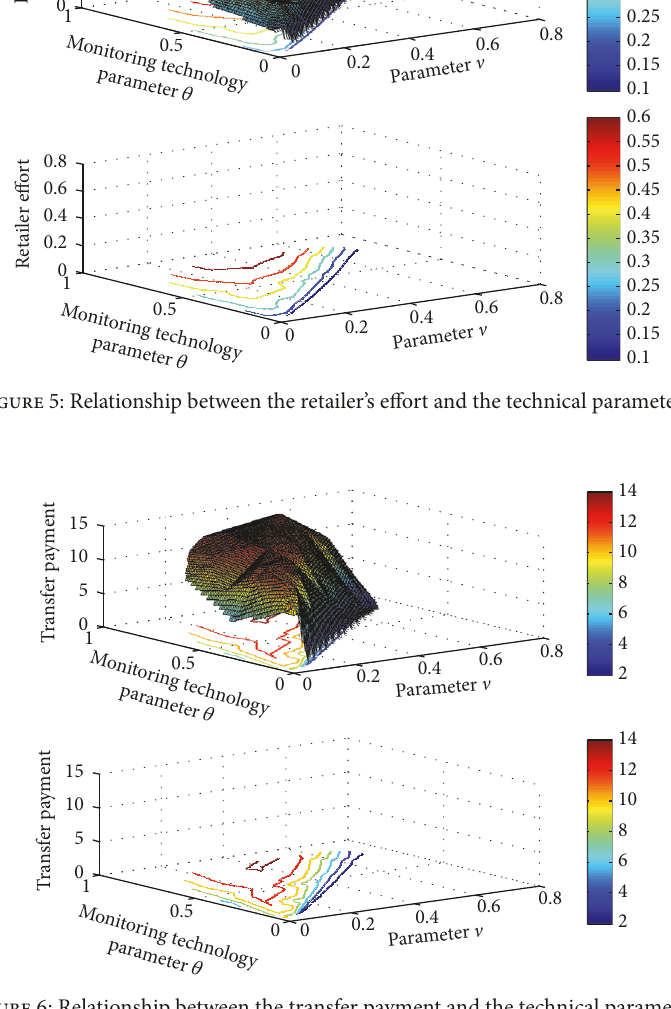
Figure 6: Relationship between the transfer payment and the technical